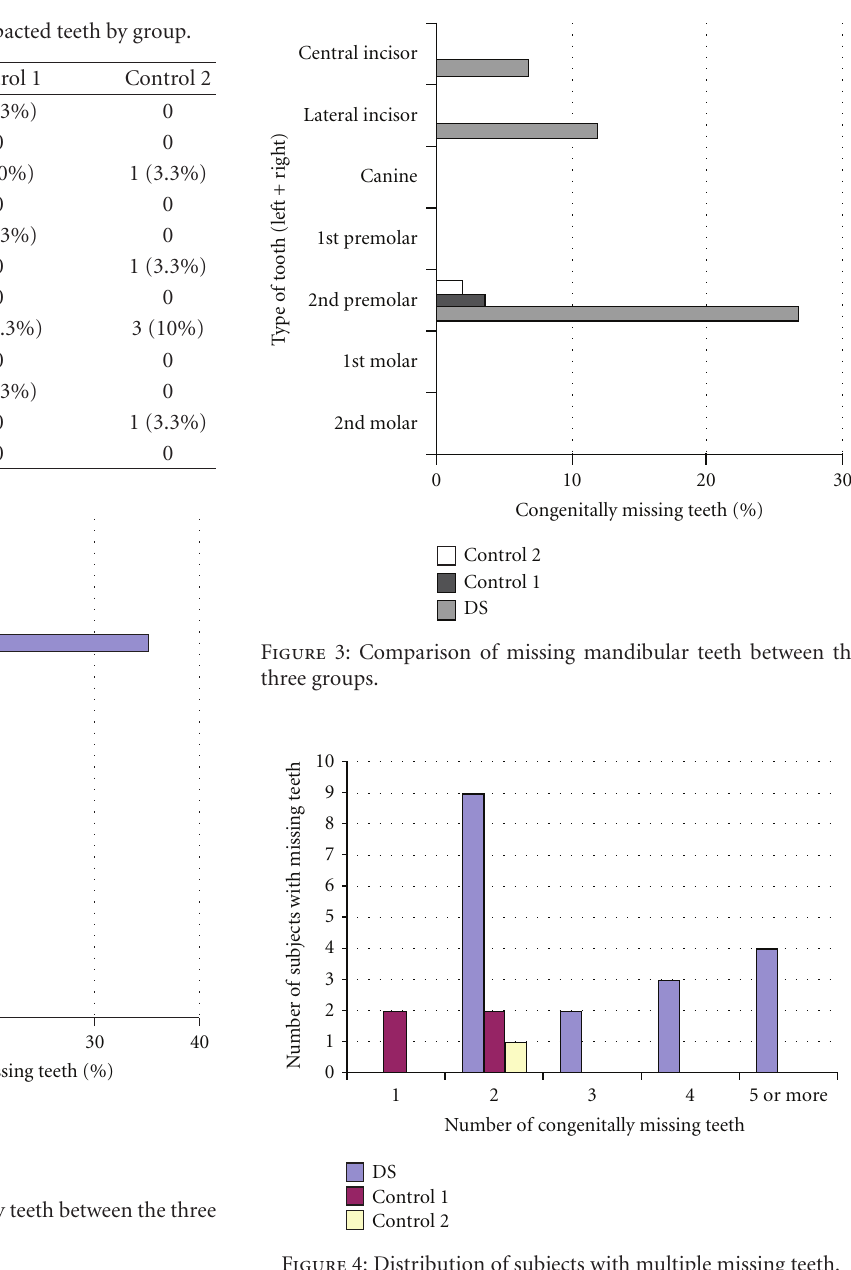
larger number of crossbites and open bites. According to Richmond et al. [15], the cuto ff for treatment of an ICON score is 43 weighted points. In the DS group, 23 of 30 patients had greater than 43, with the highest score 111 and many others in the range of 60 to 80. Only 7 DS patients had a weighted score less than 43. In Control 1, 13 of 30 patients had a weighted score of more than 43, with the highest being 67 and the lowest 13. In Control 2, 17 of 30 had a weighted score of greater than 43, with the highest being 79 and the lowest